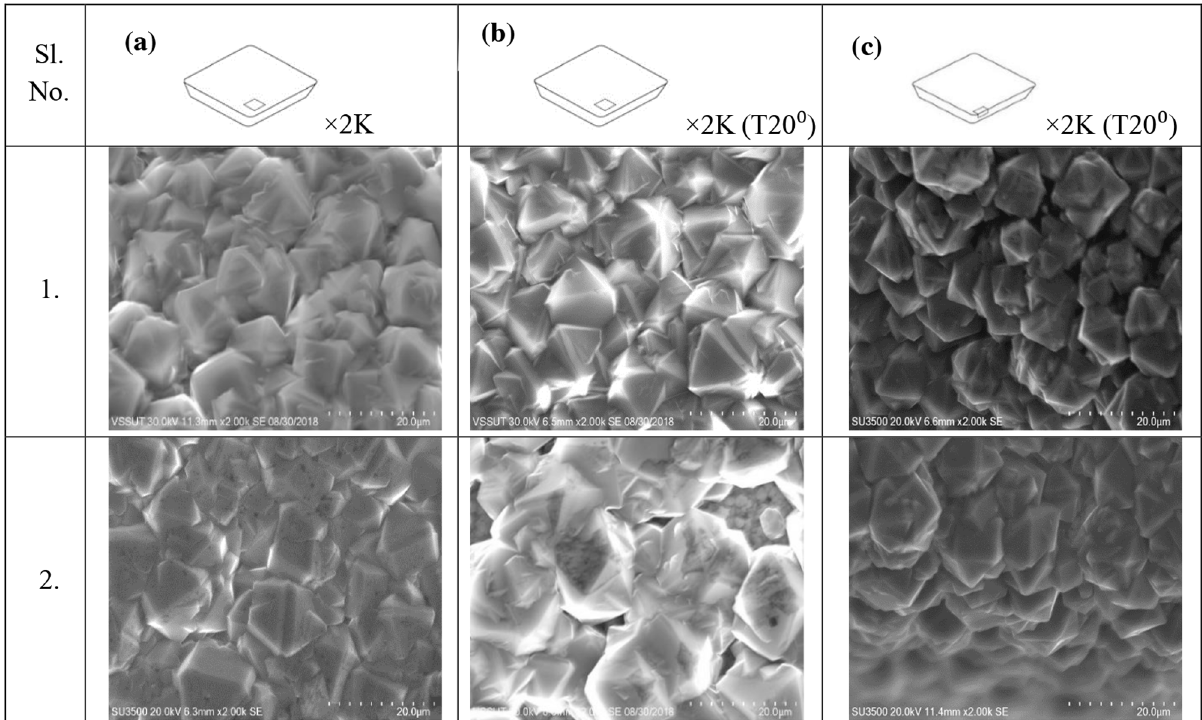
Fig. 2. SEM micrographs showing coating at the (a) surface area (b) surface at 20 ° angles (c) nose of the cutting tool at 20 ° angle.